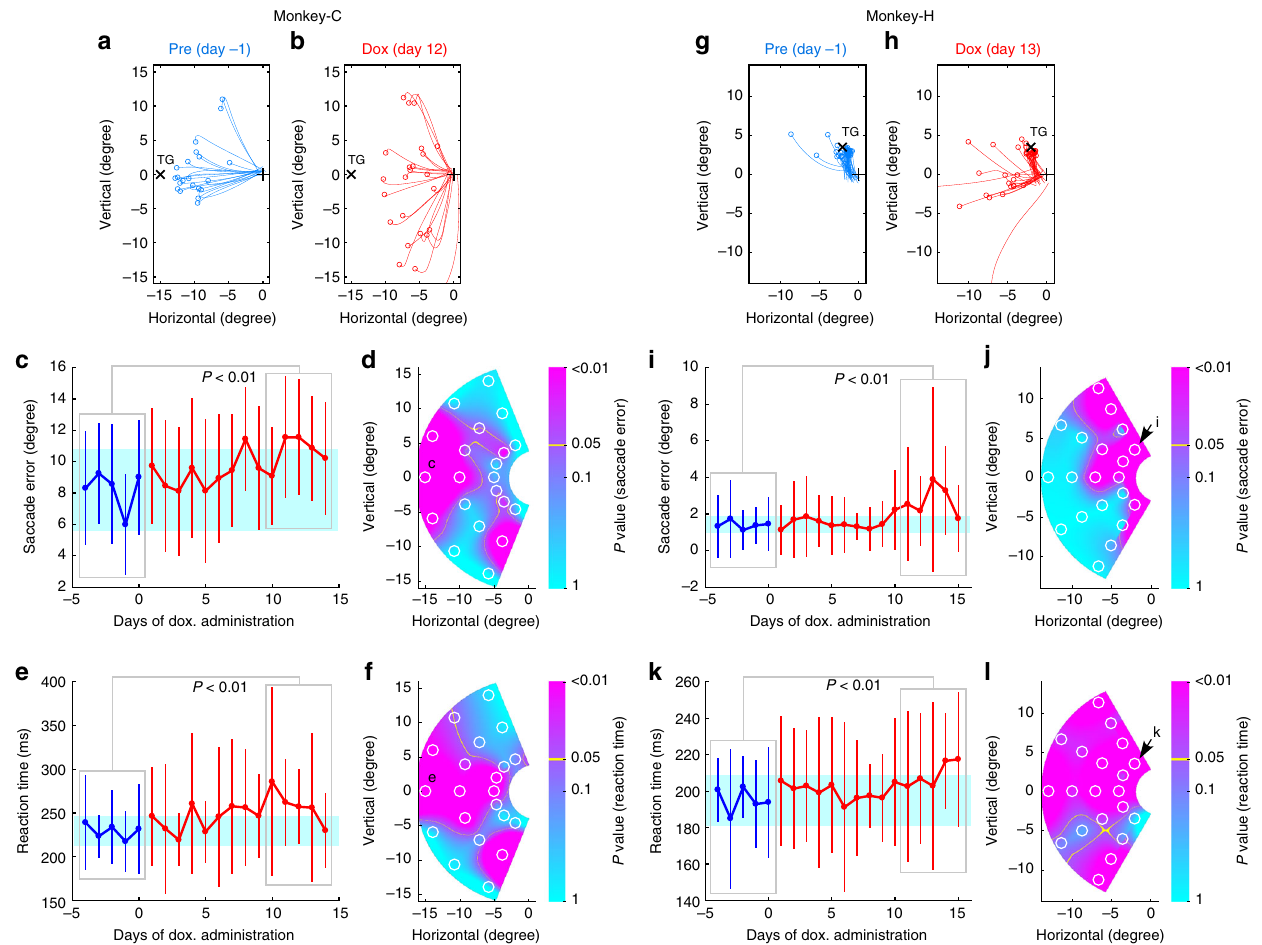
Fig. 6 Selective blockade of the SC – vlPul pathway impaired the VGS. a , b , g , h Representative saccade trajectories and saccade endpoints before administration (Pre) and during Dox administration (Dox). The marks indicate the location of saccade endpoint (o), target (x), and fi xation point ( + ). The size of saccade error (distance from target to saccade endpoint) increased in the Dox period in both monkeys. The target contrast was 0.4 for both monkeys ( a – f , Monkey-C. G-L, Monkey-H). c , i For the representative target shown in a or g , the size of saccade error is plotted against Dox administration day. Blue: before administration. Red: during Dox administration. Dot: mean of saccade error of a day. Error bar: SD. Cyan: range between mean − 2SD and mean + 2SD of the saccade error in the Pre period. The number of trials in each day was 14 – 30 ( c , e ; Monkey-C) and 40 – 49 ( i , k ; Monkey-H). The saccade error increased around 10 days from start of Dox in both monkeys ( P < 0.01, t test for set of data indicated by gray boxes). d , j P values of t test for the size of saccade error between Pre and late Dox (5-day data for each period, indicated by gray box in c or i ) are mapped on the visual fi eld with color code. For each target location, the number of trials included in 5-day data was 87 – 119 ( d , f ; Monkey-C) and 206 – 226 ( j , l ; Monkey-H). White circle indicates the target location for test. Representative target location shown in c or i is indicated by its letter on the map. The values are interpolated between tested locations. e , k For the same representative target, the reaction time (time between target appearance and start of saccade) of the VGS is plotted in the same manner as c and i . The reaction time increased in the late Dox period ( P < 0.01, t test for set of data indicated by gray boxes). f , l P values of t test for the reaction time are mapped in the same manner as d ,